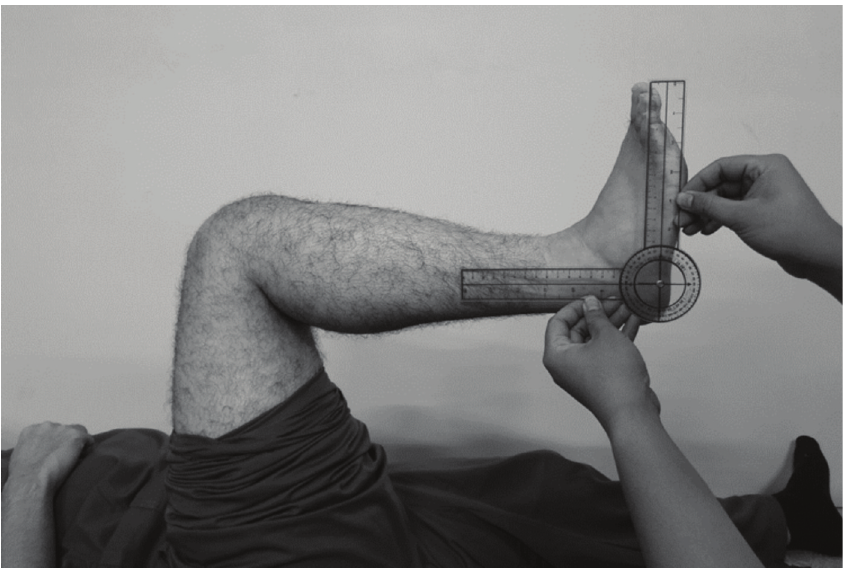
Ankle joint range of motion examination using goniometer, with 90° knee Fig. 2: